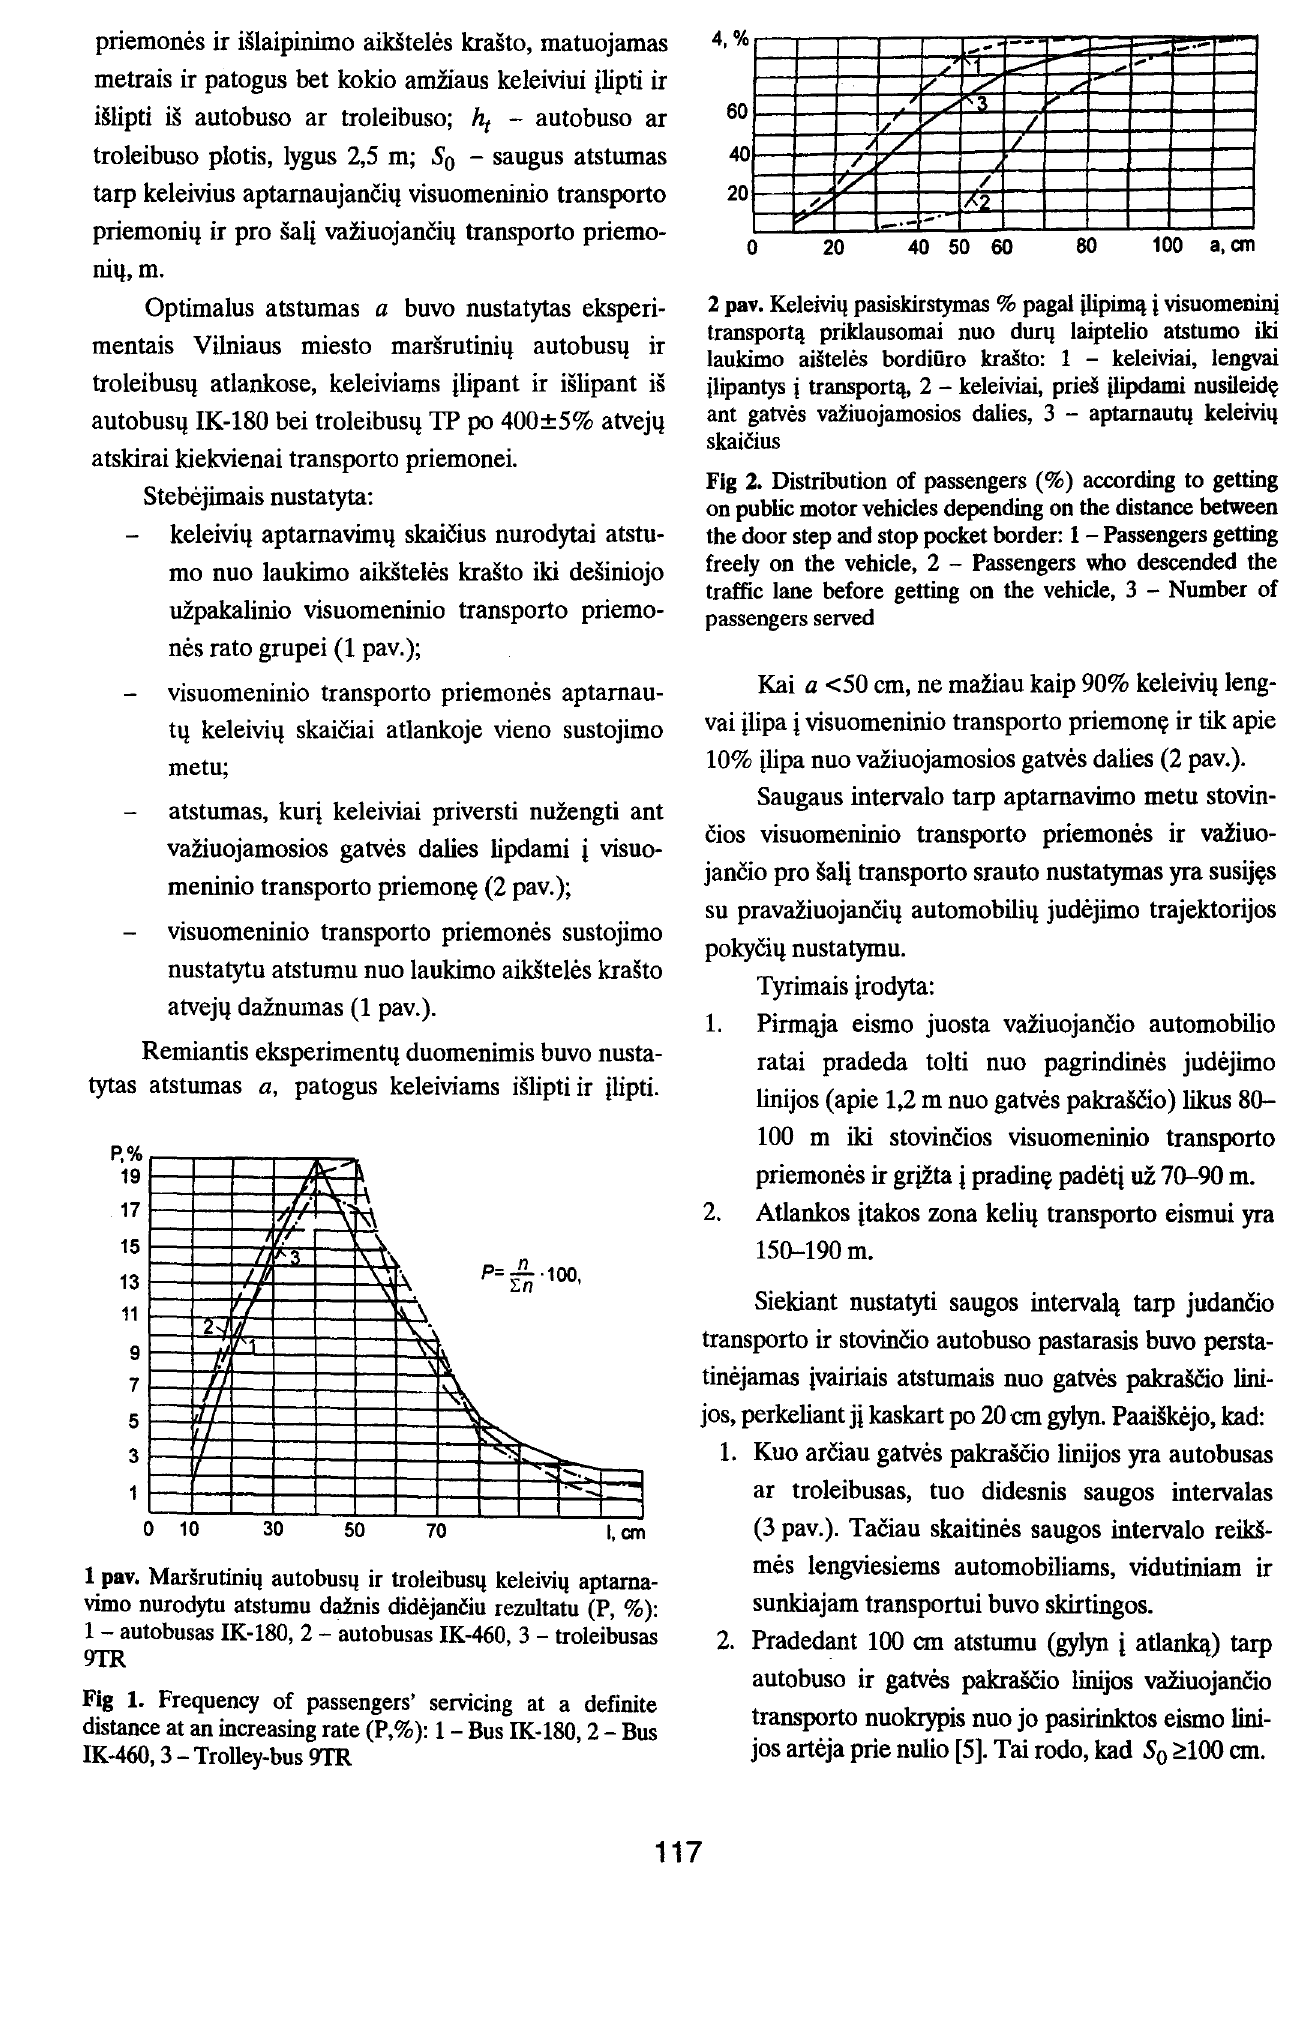
Fig 1. Frequency of passengers' servicing at a definite distance at an increasing rate (P,% ): 1 -Bus IK-180, 2- Bus IK-460, 3- Trolley-bus 9TR